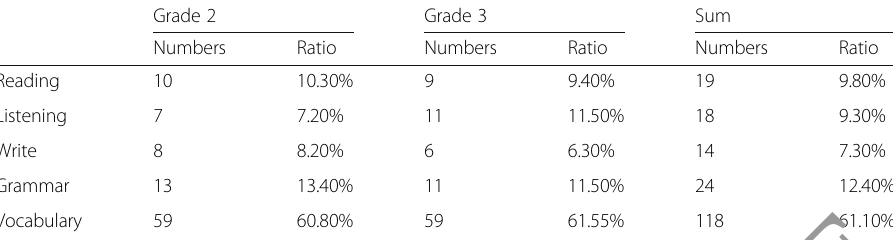
Table 1 Lexical dilemma analysis